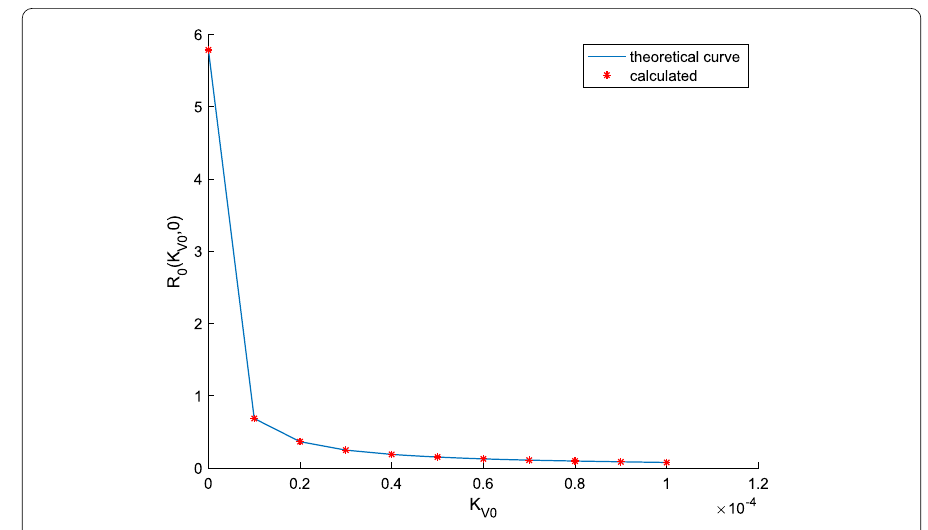
Figure 17 Variation of the basic reproduction number with vaccination and without treatment